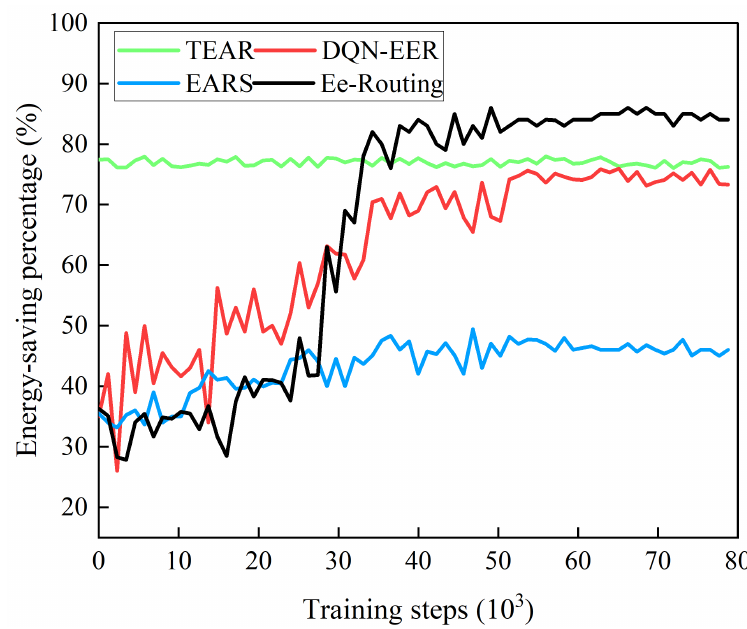
Figure 6. Energy-saving percentage under 40% traffic